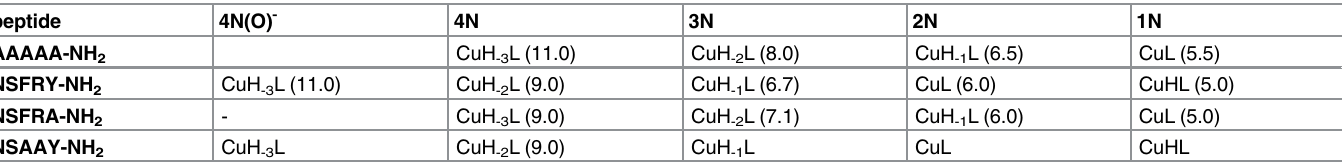
Table 1. Various complex species formed at the appropriate pH (values given in brackets), determined on the basis of spectroscopic and potentio- metric measurement [13] (the pH value for Cu(II)-NSAAY-NH 2 4N complex was estimated on the basis of UV-Vis spectra measured in the present